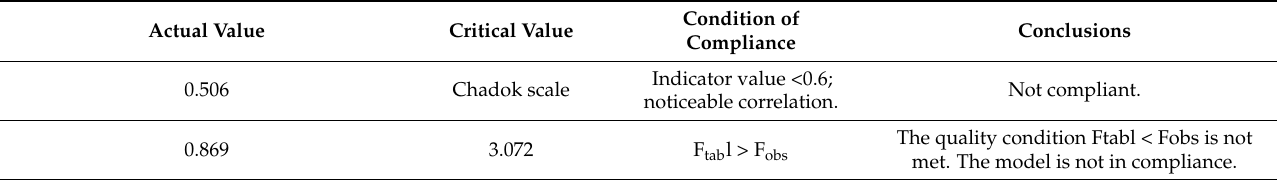
Table 2. Quality indicators of the PZ area